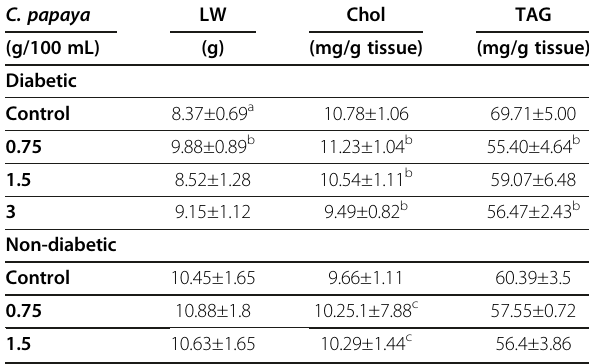
Table 4 Effect of aqueous extract of C. papaya leaf on the hepatic lipids in diabetic and non-diabetic rats C.